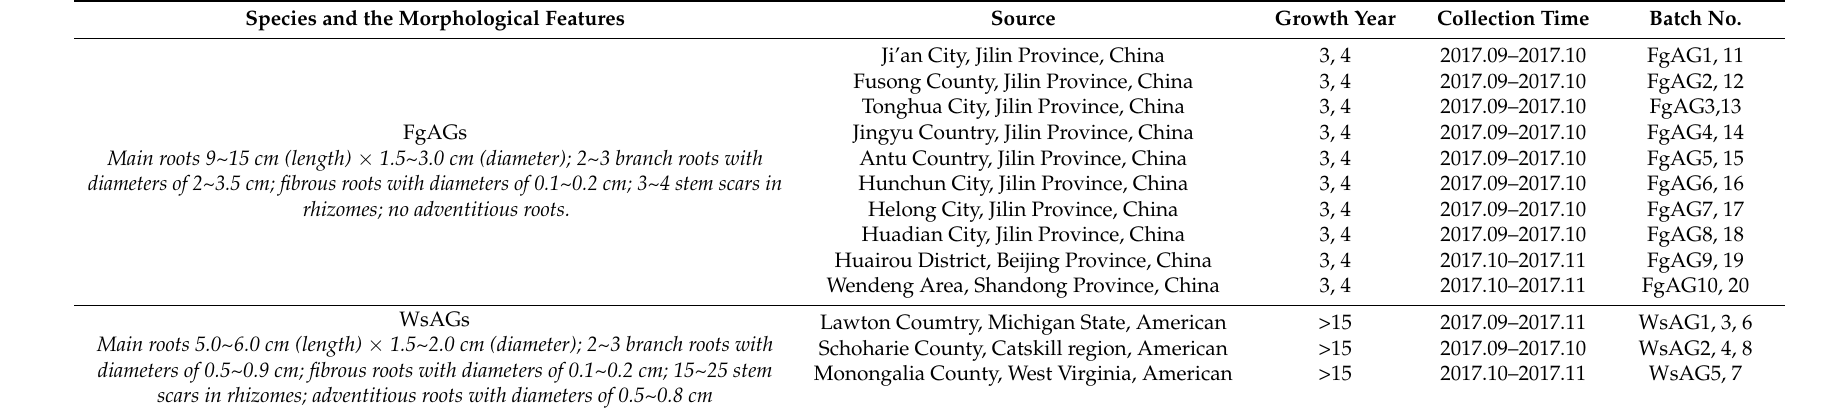
Table 2. Details of FgAG and WsAG